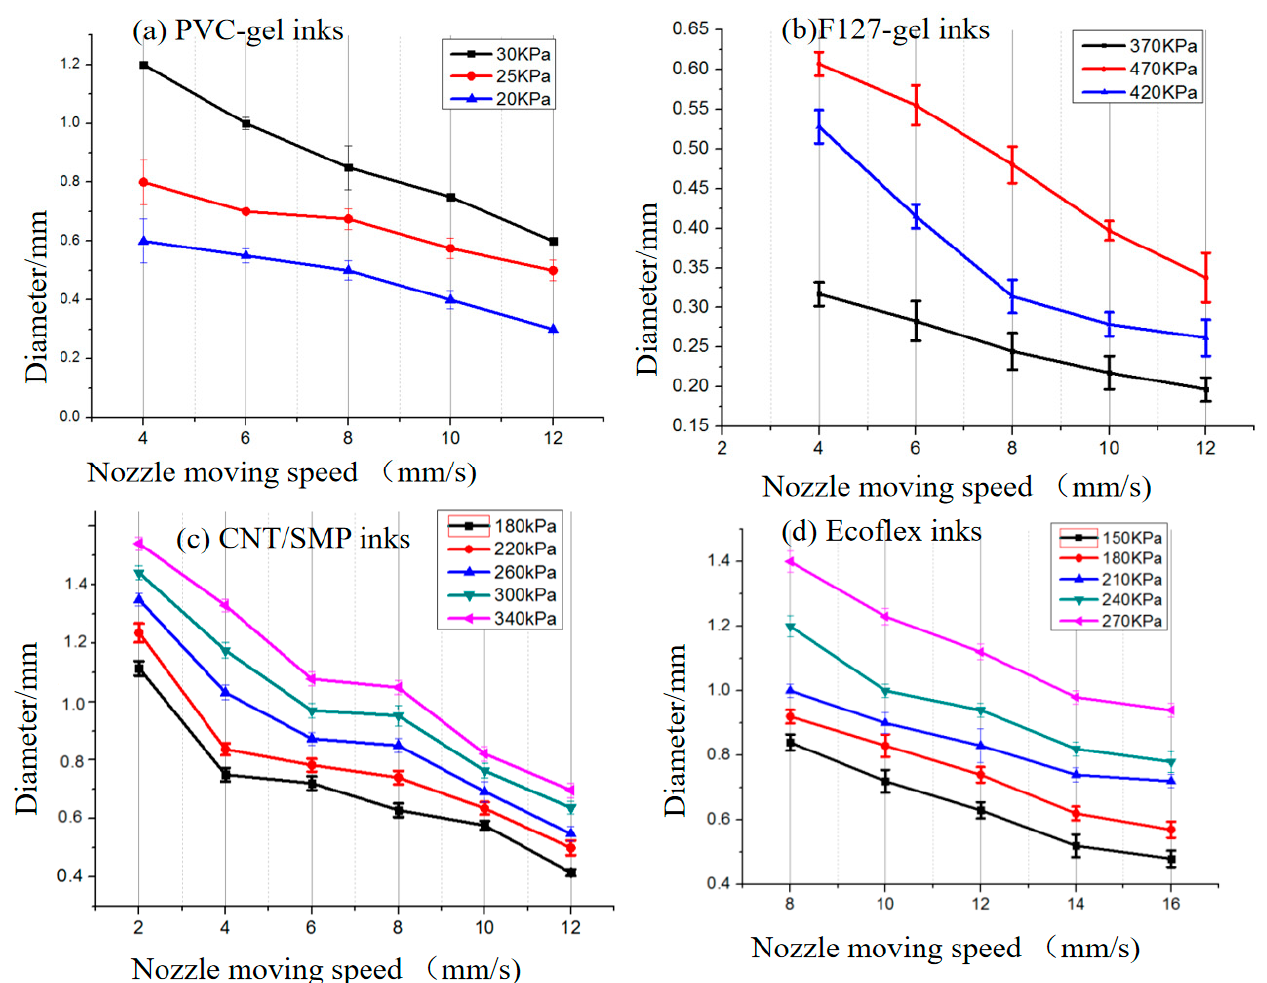
Figure 5. Influence of the extrusion pressure and nozzle moving speed on the printed diameter ( a ) PVC gel ink, ( b ) F-127 gel ink, ( c ) CNT/SMP ink, ( d ) Ecoflex ink.